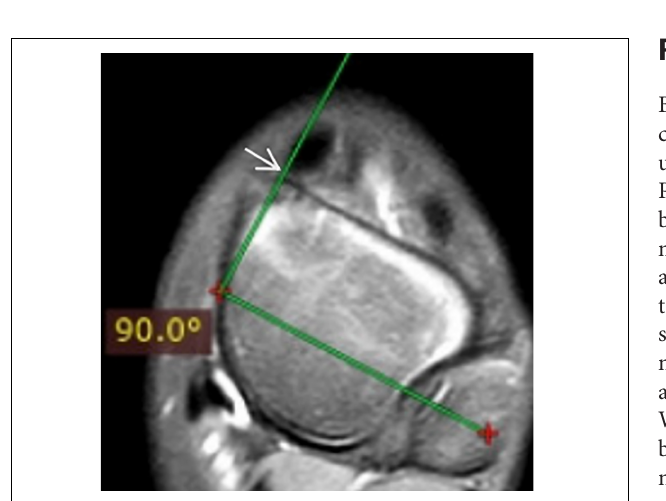
FIGURE 2 | The long axis of the talar body